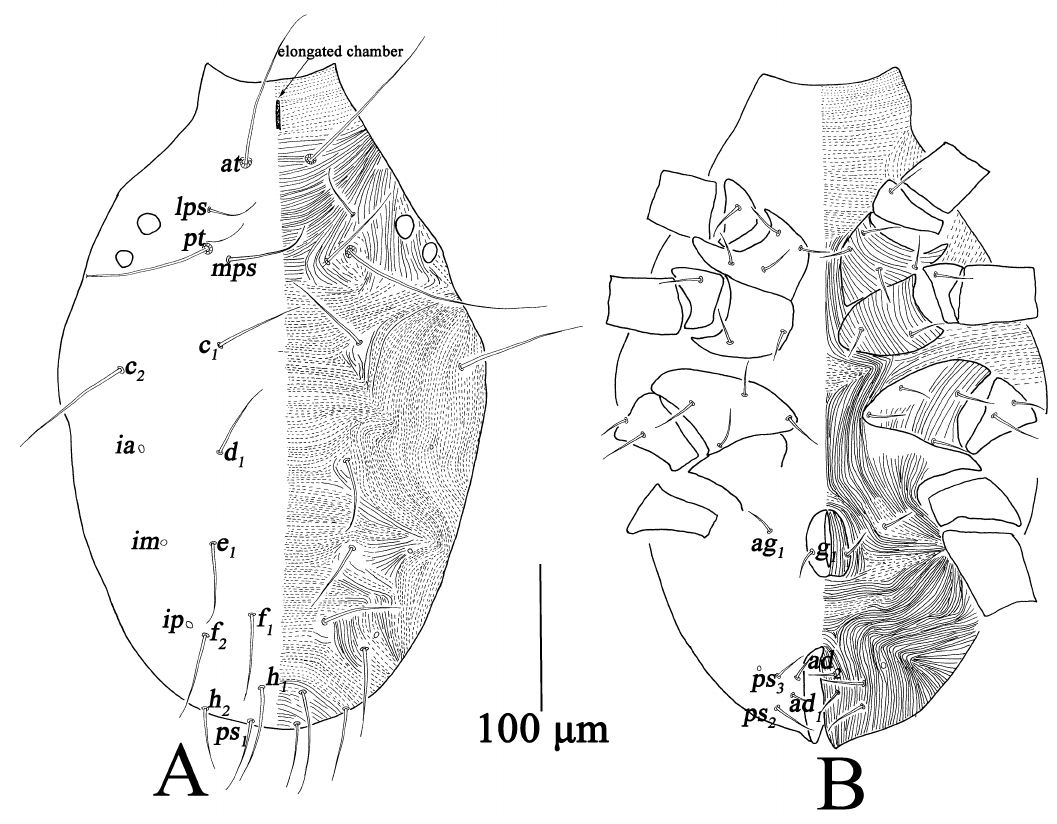
Figure 11. Bdella muscorum , protonymph: ( A ) Dorsal view of idiosoma; ( B ) Ventral view of idio- soma.